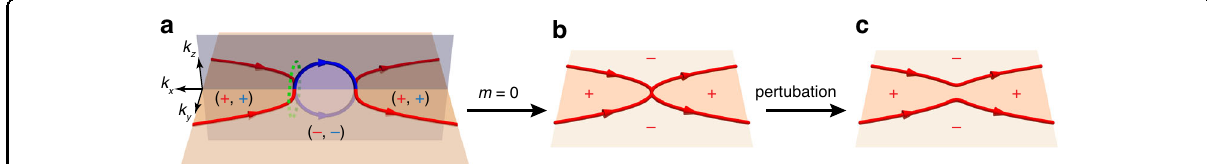
Fig. 1 Transition from orthogonal nodal chain to in-plane nodal chain and separated nodal lines. a A normal nodal chain embedded in two orthogonal mirror planes. Green circle indicates the π 1 homotopy loop. b The blue nodal ring can be shrunk continuously by tuning the system parameter m (see text), resulting in an in-plane nodal chain when m = 0. c Further perturbation fi nally gaps the chain point. For all panels, “ ± ” indicates the signs of mirror symmetries eigenvalues, red color for M z and blue color for M y . Within the framework of the two-band model, the eigenstates bounded inside the red (blue) degeneracy lines are of even (odd) parity, those outside are of odd (even) parity. Arrows indicate orientations of nodal lines with Z classi fi ed topological charges in a real two-band